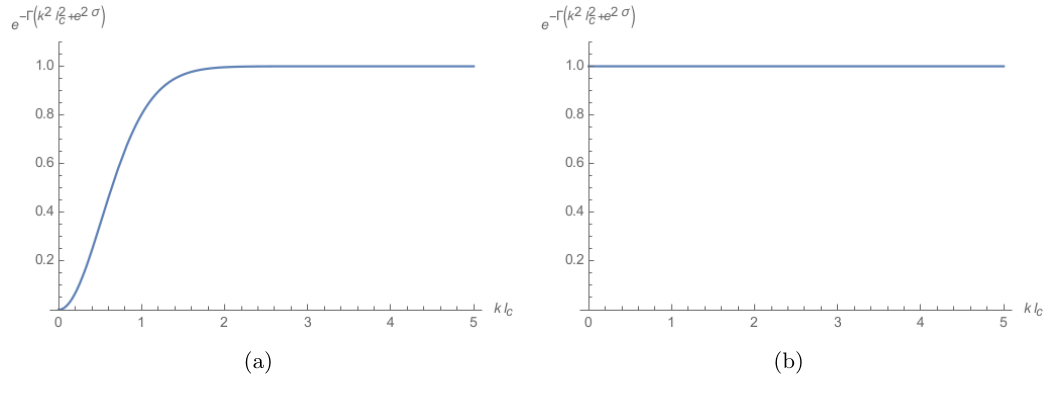
Figure 7 . e (cid:0) (cid:0) [ ( kl c ) 2 + e 2 (cid:27) ] plotted as a function for kl c for (a) e (cid:27) = 10 (cid:0) 2 and (b) e (cid:27) = 10 2 . For e (cid:27) (cid:28) 1, the kernel disperses quadratically in k at small momenta before the dispersion is lost at large momenta with k (cid:29) l (cid:0) 1 . For e (cid:27) (cid:29) 1, the momentum dependence is suppressed at all momenta, c and the wavefuction becomes a direct product state in space.